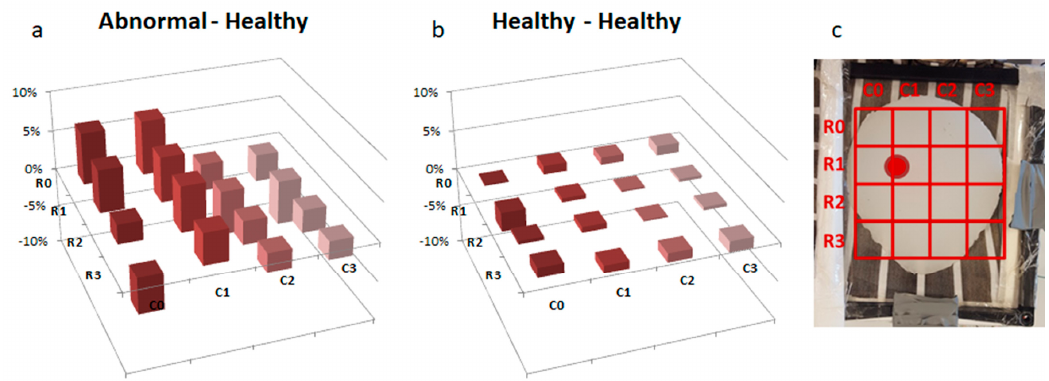
Figure 14. Ability of the textile pressure sensing matrix to detect the presence of a stiffer inclusion at R1,C0-R1,C1 in the breast phantom. The phantoms were pressed with a load of 672 Pa against the matrix. ( a ) Differences (in %) between healthy–abnormal acquisition; ( b ) differences (in %) of two acquisitions with two healthy phantoms; and ( c ) position of the inclusion during the registration.